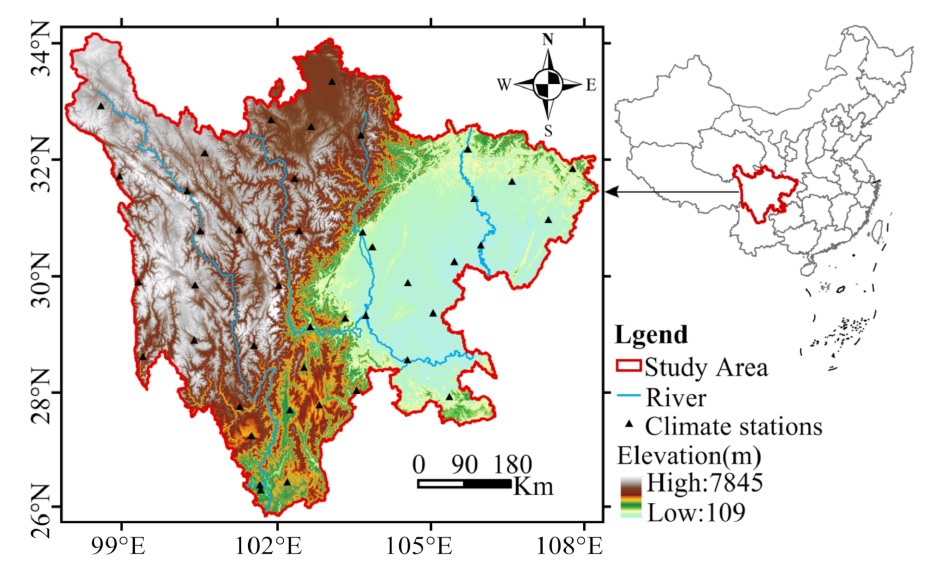
Figure 1. Location of the study